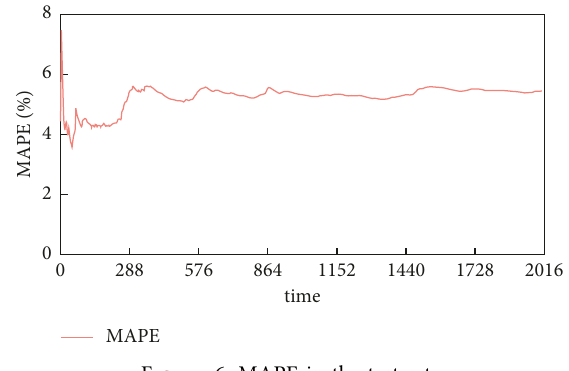
Figure 6: MAPE in the test